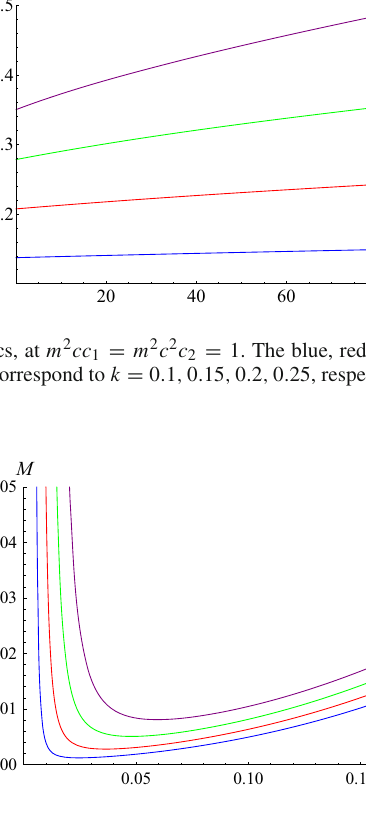
Fig. 3 The mass function, given at Eq. (25), is plotted in terms of the horizon radius for the different values of the characteristic parameter k of the non-linear electrodynamics, at l = m = c = c 1 = 1. The blue,